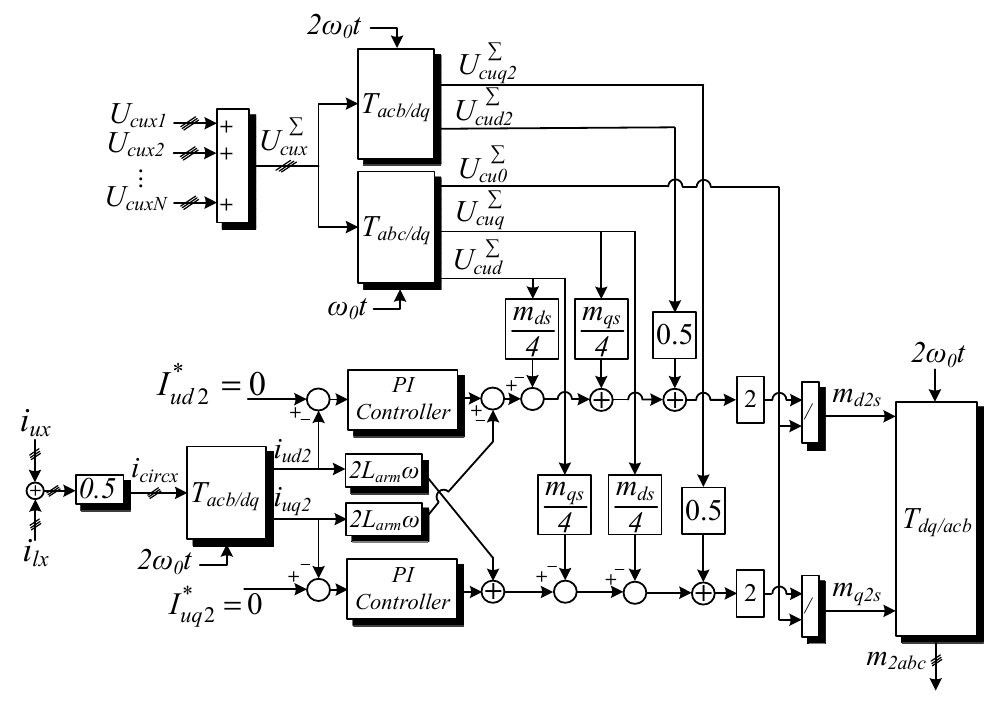
Figure 2. Circulating current control algorithm.